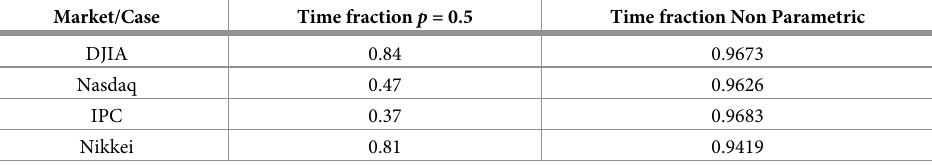
Table 12. Fraction of time, the overall of the studied data trends durations follow a geometric distribution with parameter p = 0.5, and with any p , both cases for a significance level of